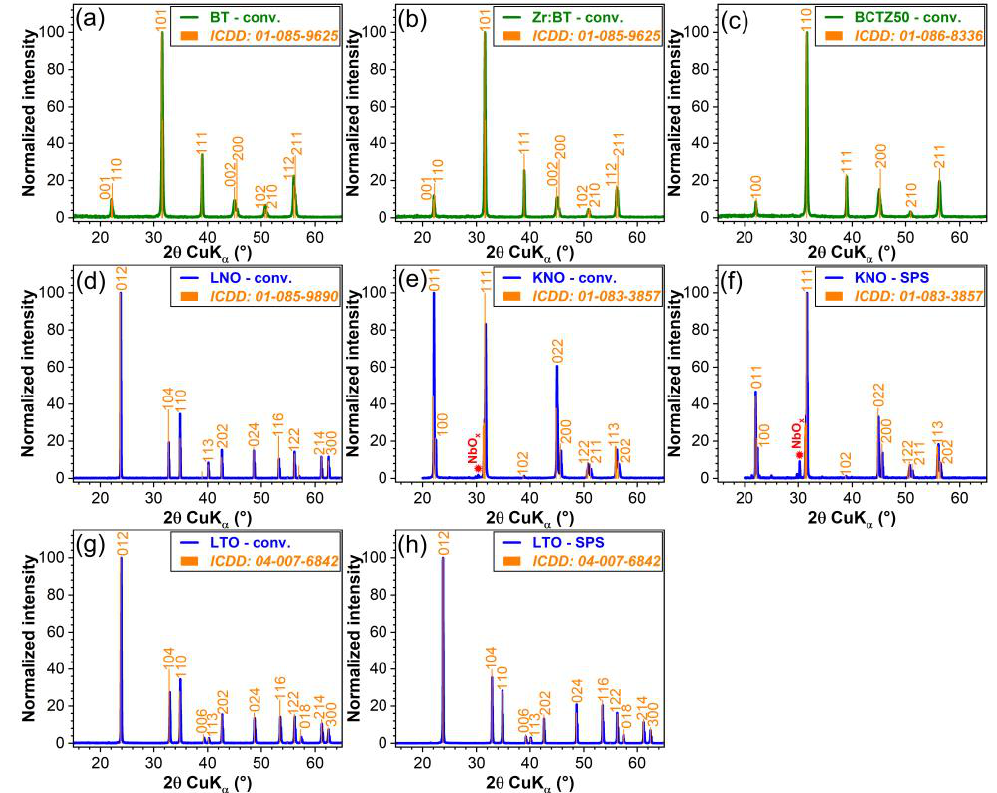
Figure 1. XRD diagrams of sintered ceramics: ( a ) BT; ( b ) Zr:BT; ( c ) BCTZ50; ( d ) LNO; ( e , f ) KNO; and ( g , h ) LTO, sintered conventionally (conv.) ( a – e , g ) or by ( f , h ) SPS. The ICDD reference diffraction lines of each targeted phase are presented (in orange colour) alongside the corresponding sample XRD pattern.